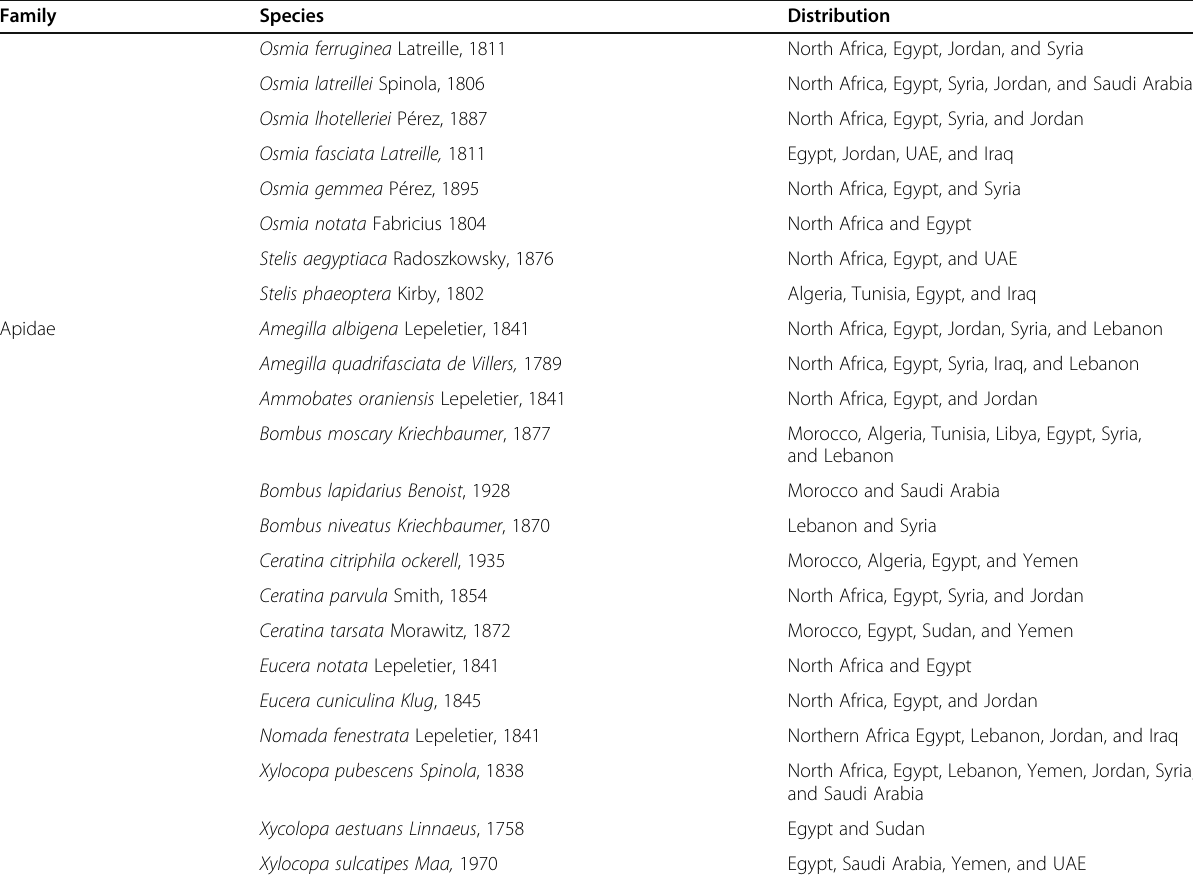
Table 1 List of some common species in North Africa and Middle East (Louadi et al., 2008; Dathe et al., 2009; Grace, 2010; Bendifallah et al., 2010a; Bendifallah et al., 2012; Kuhlmann et al., 2012; Bendifallah et al., 2013; Shebl et al., 2013; Shebl & Farag,